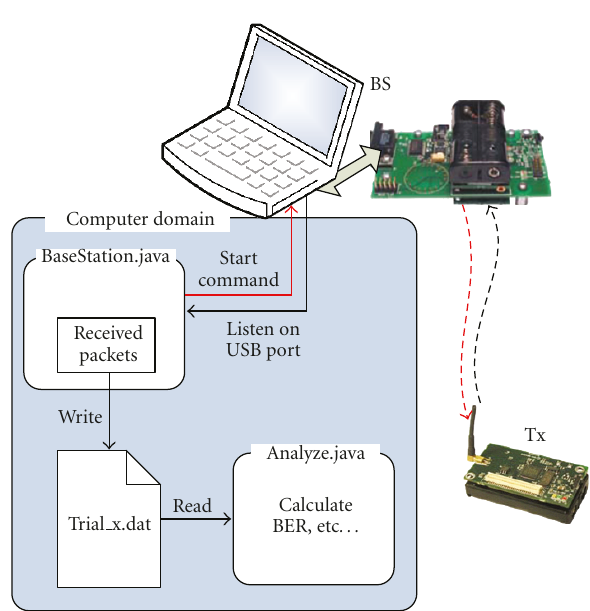
Figure 2: Testbed